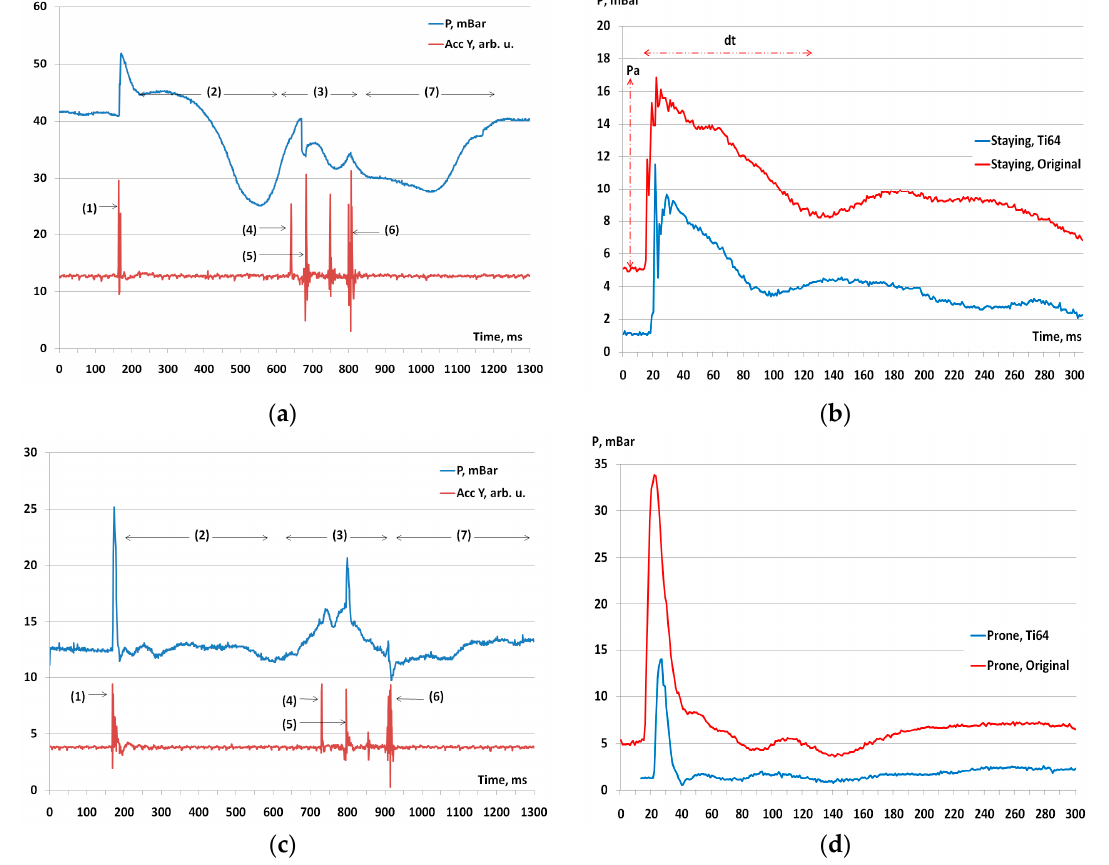
Figure 3. Typical signal traces recorded from pressure sensor and accelerometer (Y component) during shooting in standing ( a , b ) and prone ( c , d ) positions. Plots in figures ( a ) and ( c ) reflect true pressure values, including steady state before and after the shot, but the accelerometer signal is scaled for better event identification. Plots in figures ( b ) and ( d ) reflect the pressure changes, but are offset for a better